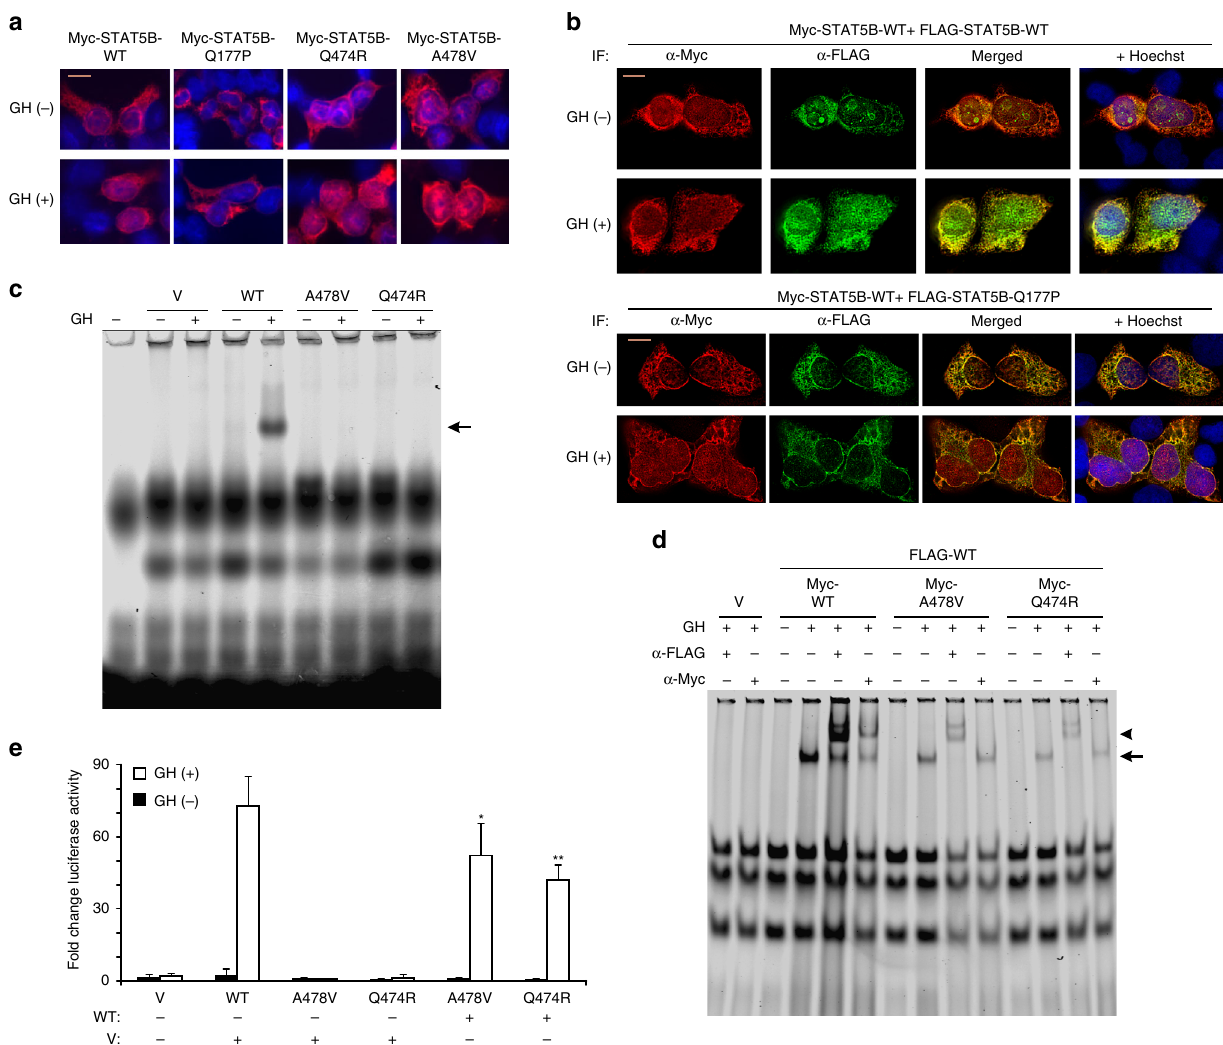
Fig. 3 STAT5B missense variants are defective in nuclear translocation or DNA binding. a Representative immuno fl uorescence images of untreated or GH- stimulated HEK293(hGHR) cells transfected with Myc-STAT5B wild type (WT) or Myc-STAT5B variant plasmids (as indicated, abbreviations as in Fig. 2) and stained with α -Myc antibodies and Hoechst 33342 nuclear staining (scale bar, 10 µ m). b Images of GH-stimulated or untreated HEK293(hGHR) cells transiently transfected with Myc-STAT5B wild type (WT) and co-transfected with plasmids expressing WT (upper panel) or p.Gln177Pro STAT5B (Q177P, bottom panel) followed by immunostaining (IF) with α -FLAG or α -Myc antibodies and Hoechst 33342 (scale bar, 10 µ m). c , d Representative (three independent experiments) electrophoretic mobility shift assays (EMSA) ( c ) or supershift EMSA ( d ) to demonstrate DNA-binding of STAT5B WT and/or variant proteins as indicated. d Supershift EMSA of FLAG-WT co-transfected with indicated Myc-tagged WT or variants (V, vector only control; arrow, shifted; arrowhead, supershifted complexes). e Luciferase reporter activity measured in HEK293(hGHR) cells co-transfected with equimolar amounts of the indicated FLAG-tagged plasmids. Activities are presented as fold increase above unstimulated vector control, which was arbitrarily assigned a value of 1.0. Error bars represent mean ± S.D. of four independent experiments, each time in duplicates. * p < 0.05, ** p < 0.01 relative to GH-stimulated WT,